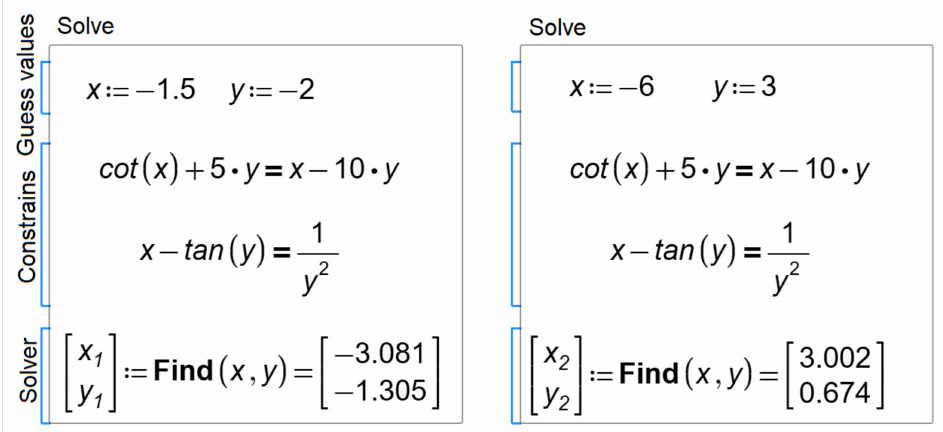
Figure 3. Mathcad instructions for the numerical solution of (1).